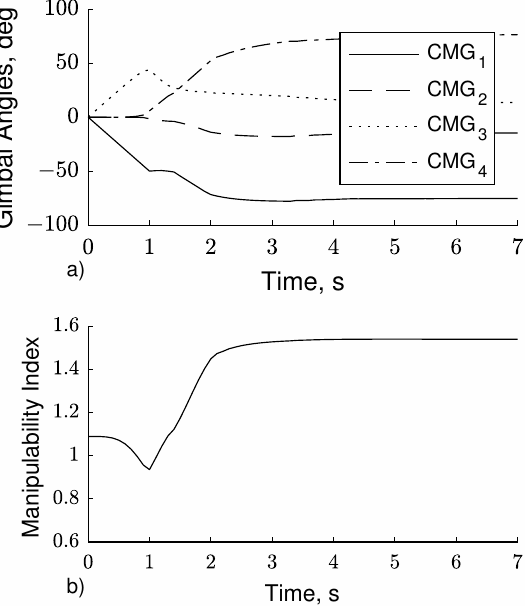
Figure 8. Simulation results with NSP. ( a ) Gimbal angles, ( b ) Manipulability index.